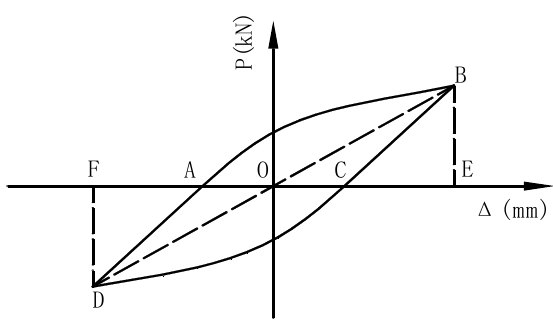
Figure 6. Calculation of equivalent dissipation coefficient.